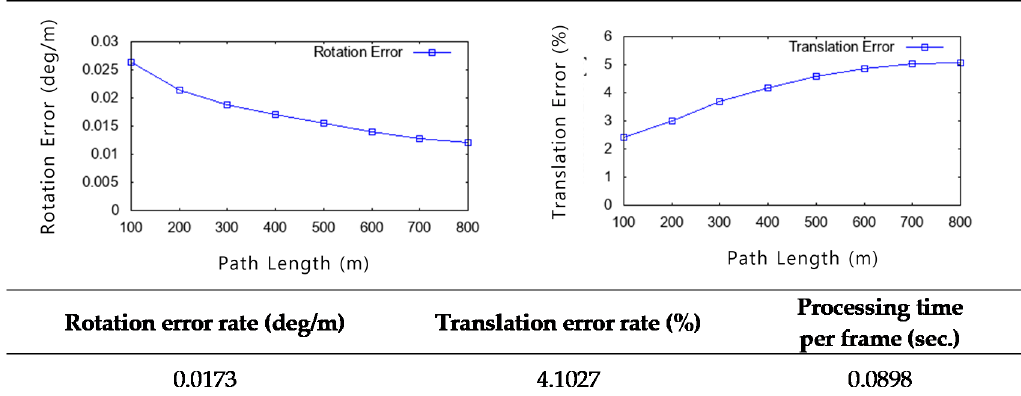
Figure 15. Graph of error over mileage for sequence 00.